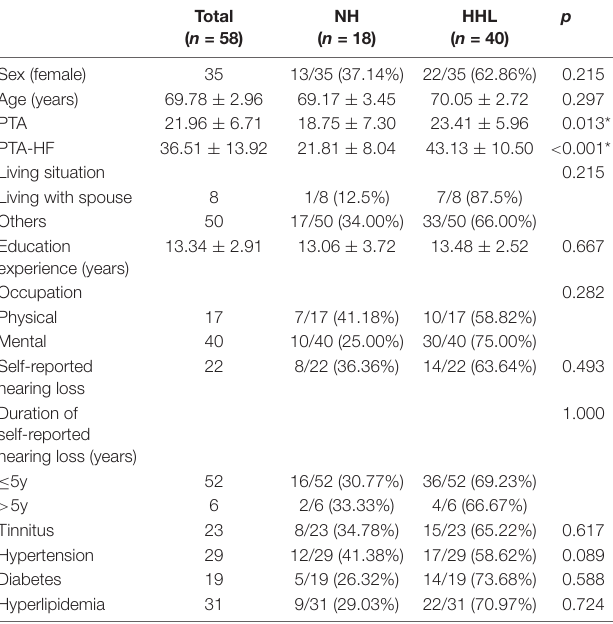
TABLE 3 | The epidemiology and clinical characteristics of the HHL group and NH groups.